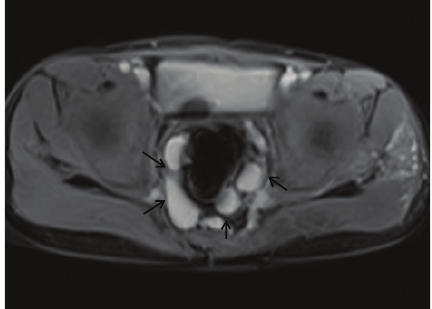
Figure 9: A 9-year-old boy with bleeding per rectum since he was 1 year old. Axial MR image of the same patient as above reveals abnormal perirectal vascular channels (arrows).